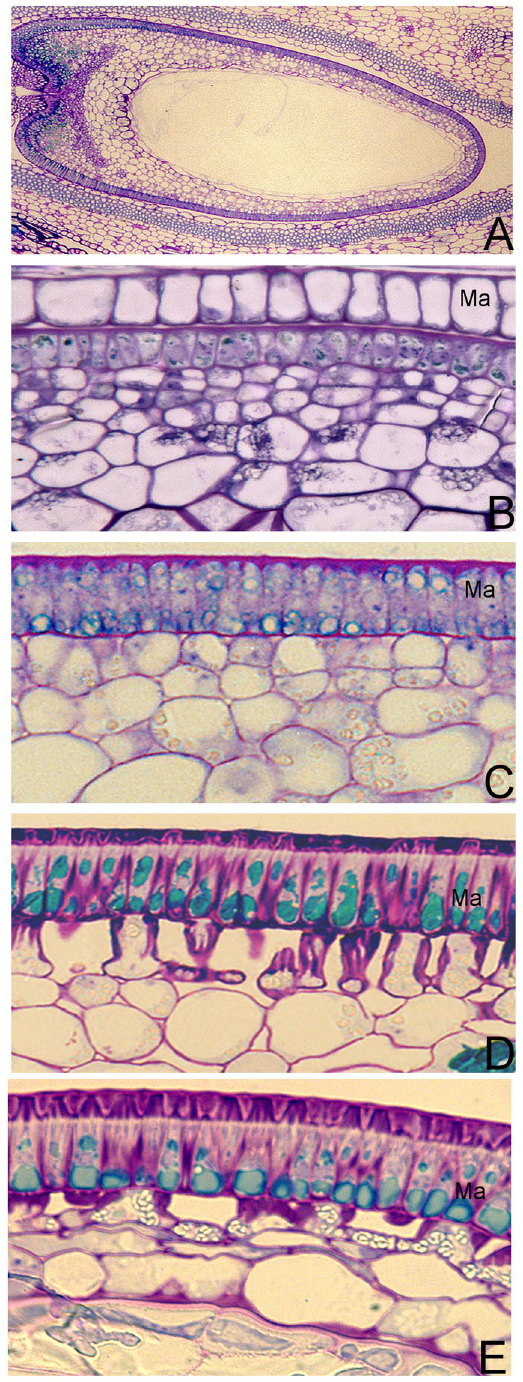
Figure 2. Light micrographs of developing M . truncatula MC stained with Toluidine Blue O. Ma presents MC of the seed coat. ( A – D ) Cross-sections through seed coats at ( A ) 3 DPP, ( B ) 6 DPP, ( C ) 13 DPP, ( D ) 20 DPP, and ( E ) 27 DPP, respectively. Phenolic compounds stain